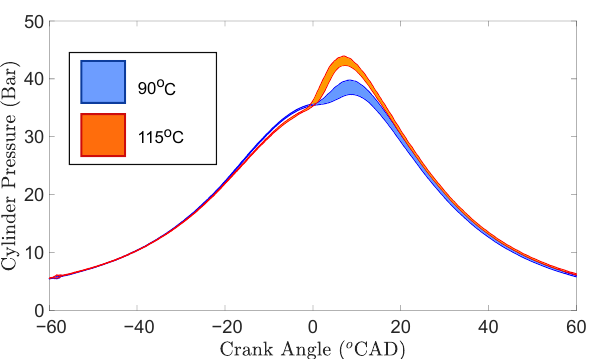
Figure 11. Combustion pressure for HT at T inlet 90 ◦ C (blue) and 115 ◦ C (red). Solid region indicates the range of combustion pressures collected. Plotted as an alternative to plotting all 8 combustion pressures as individual